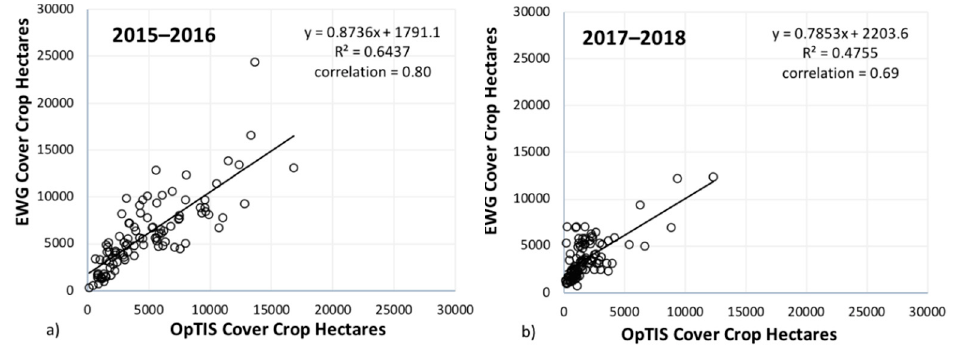
Figure 12. Comparison of county ‐ level cover crop hectares for Iowa in ( a ) 2015 to 2016 and ( b ) 2017 to 2018 as estimated by OpTIS ( x ‐ axis) and the Environmental Working Group (EWG) ( y ‐ axis).